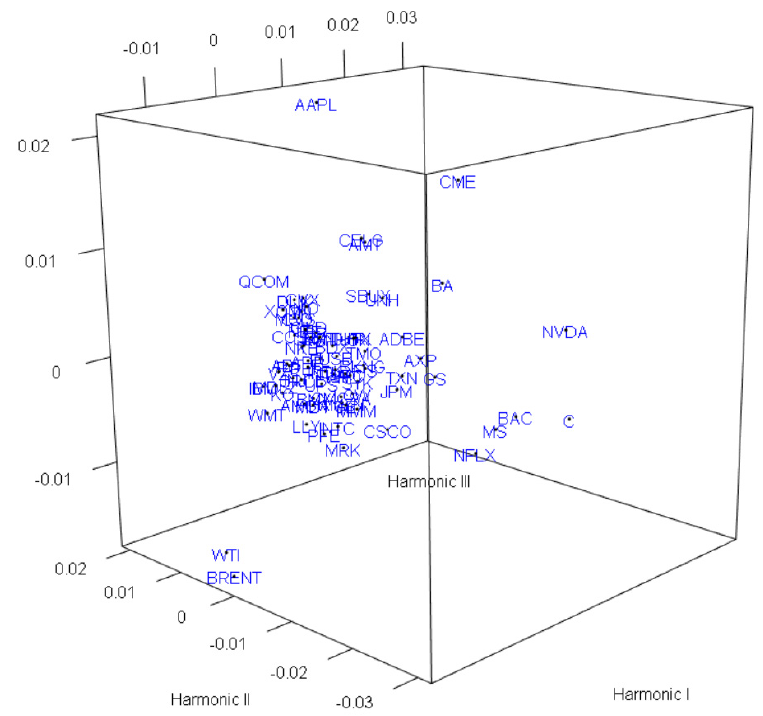
Figure 5. The 3D FPCA. Note: Harmonic I: 1st component; Harmonic II: 2nd component; Harmonic III: 3rd component.